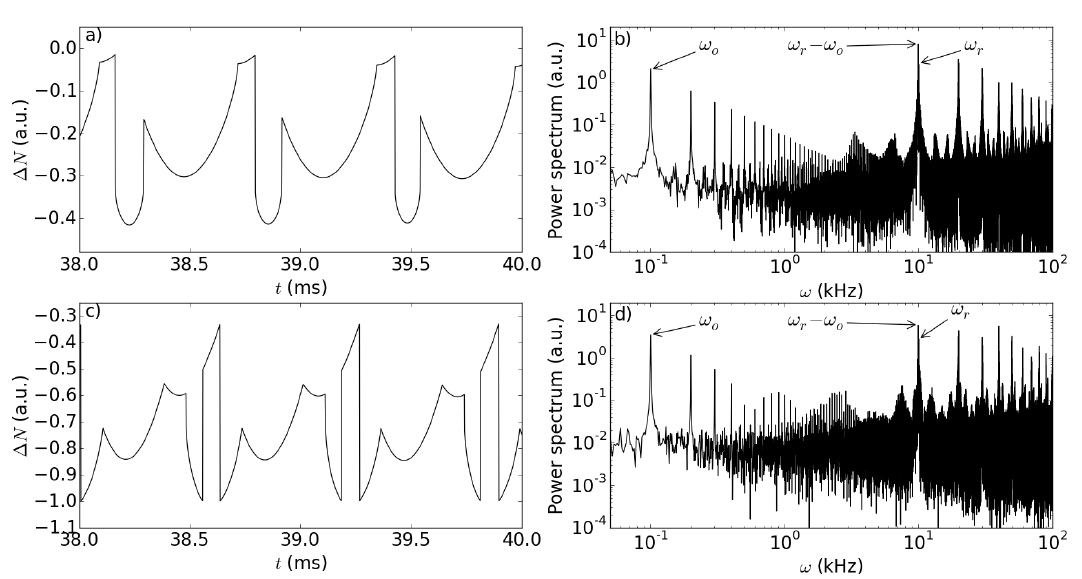
= 0 . 0404 ; lower part: k r